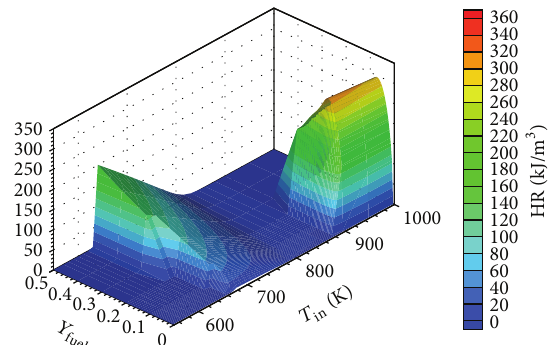
Figure 1: Predictions of heat release per unit volume as a function of inlet temperature and fuel concentration ( 𝑡